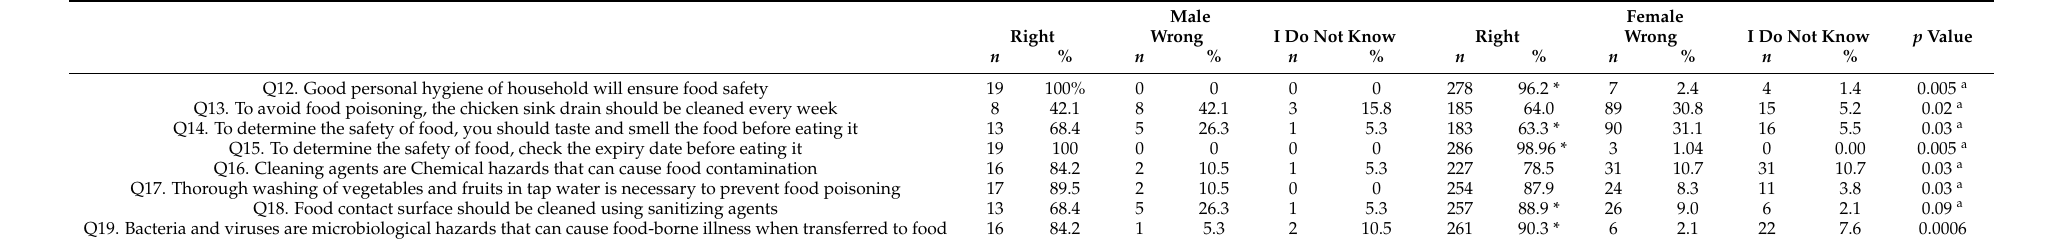
a Kruskal-Wallis Test. * Indicates to the highest percentage. Table 6. Responses to statements concerning food safety